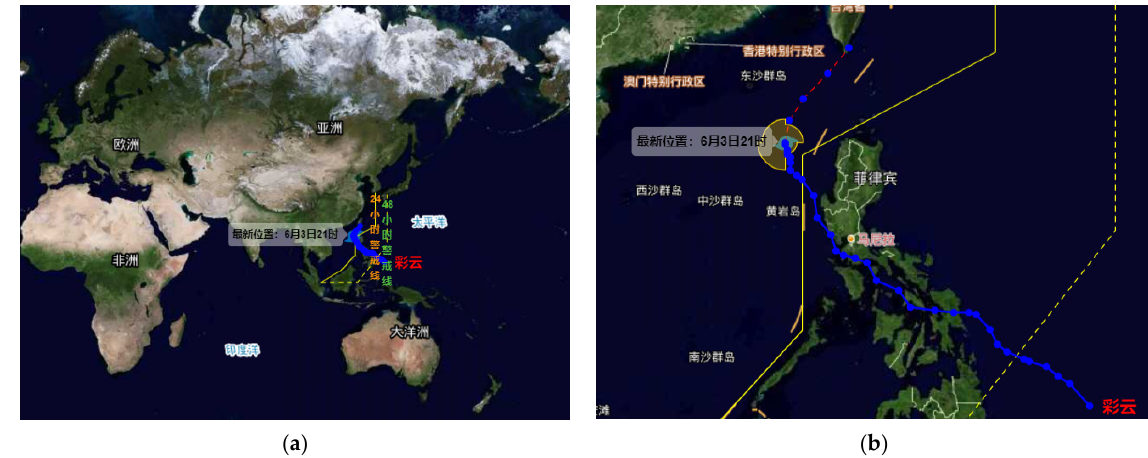
Figure 1. Information display of typhoon network of Central Meteorological Station. ( a ) Meteorological cloud map and typhoon route. ( b ) Real time information monitoring and route prediction of Typhoon.